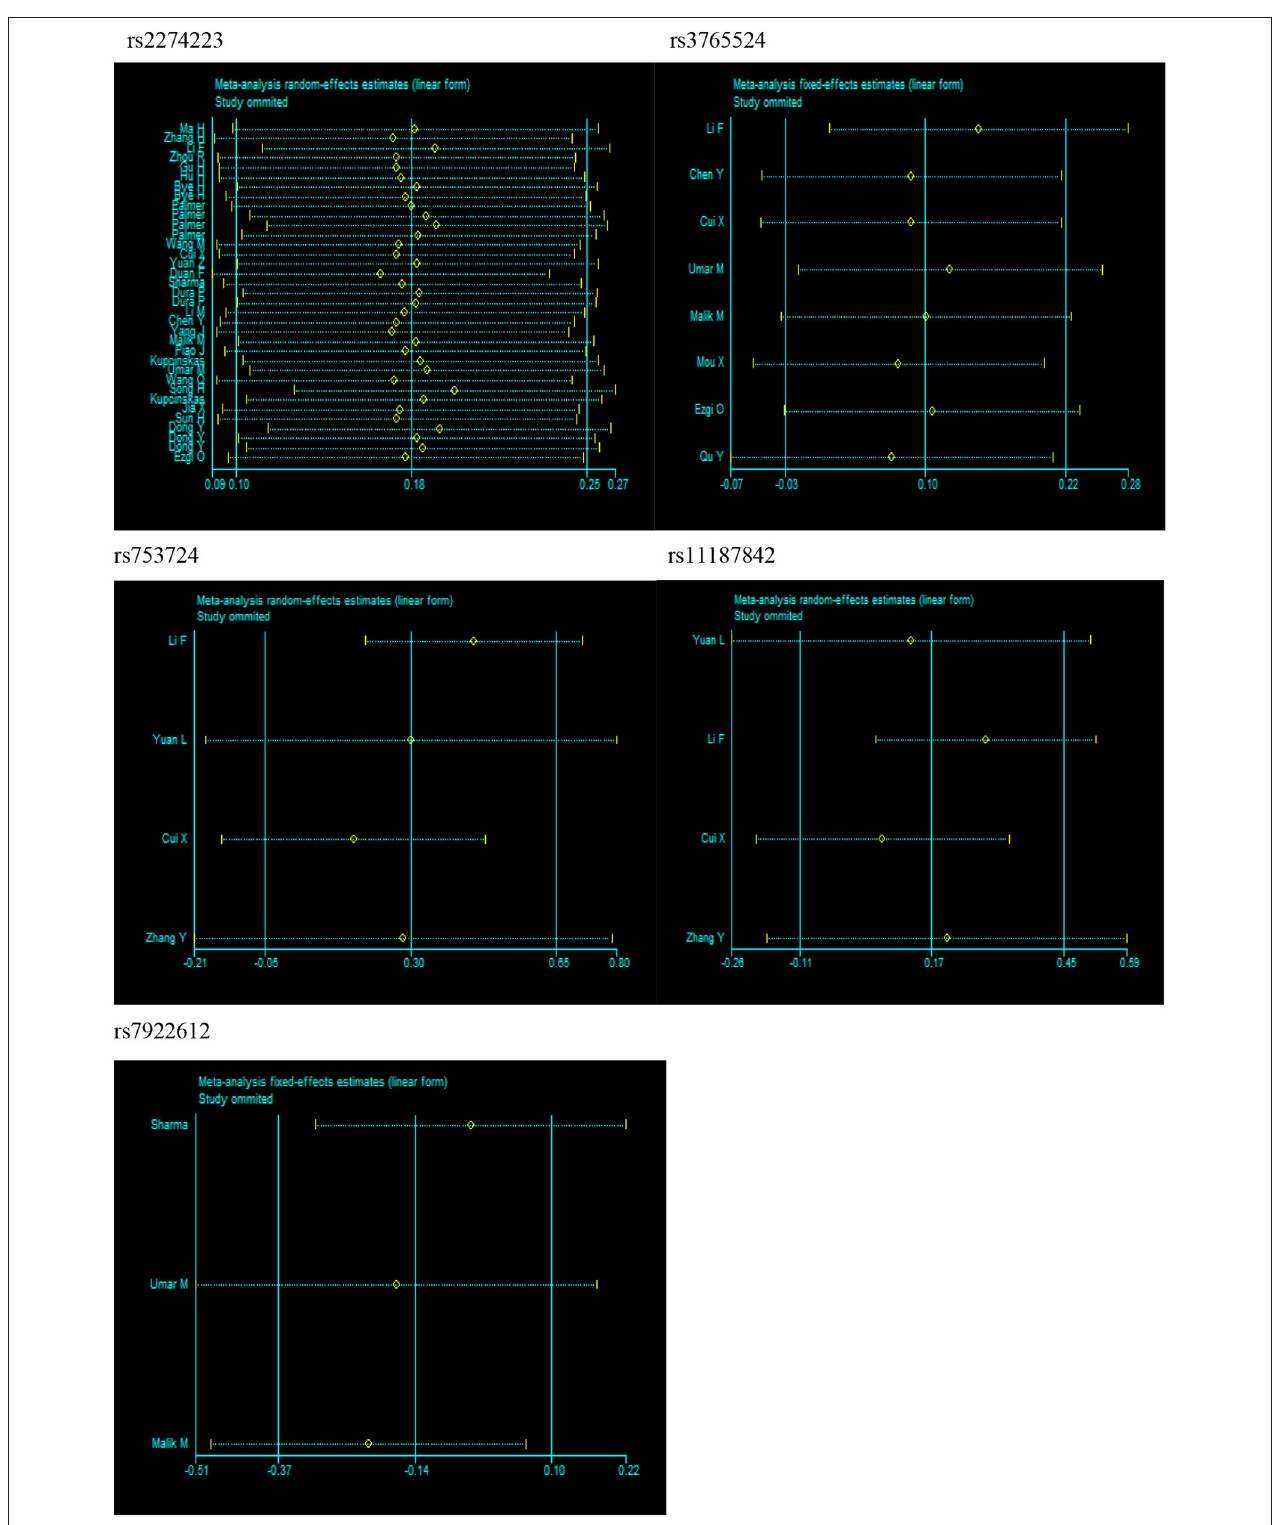
FIGURE 4 | Sensitivity analysis for PLCE1 polymorphisms and cancer risk in dominant model (rs2274223: AG + GG vs. AA; rs3765524: CT + TT vs. CC; rs753724: GT + TT vs. GG; rs11187842: CT + TT vs. CC; rs7922612: CT + TT vs. CC).